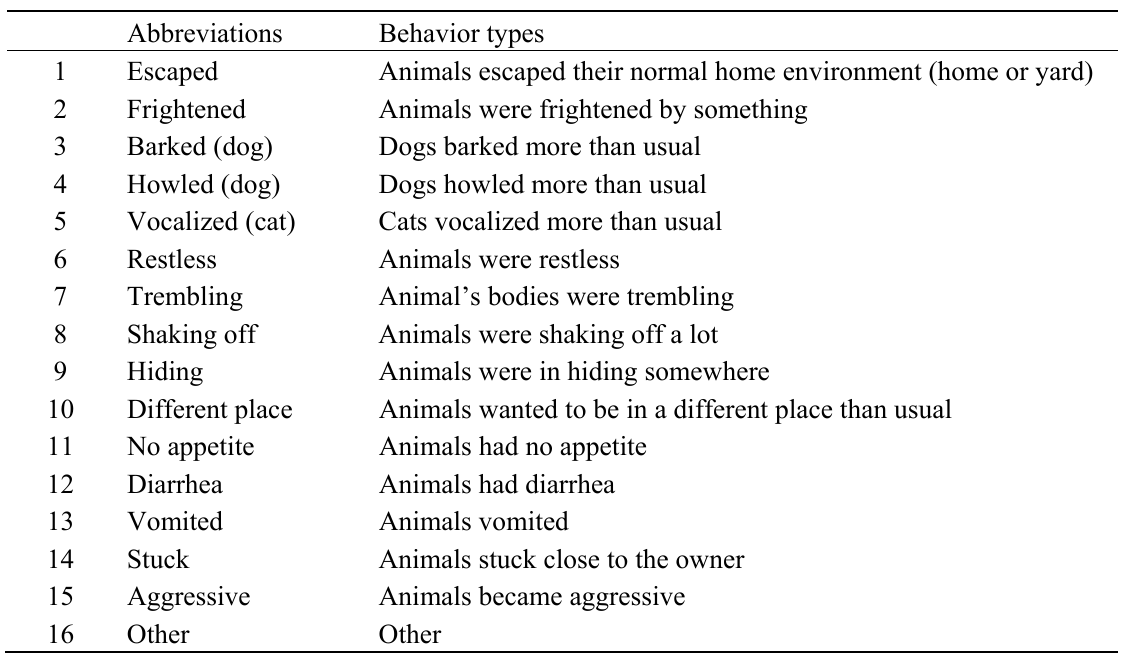
Table 1. Types of unusual animal